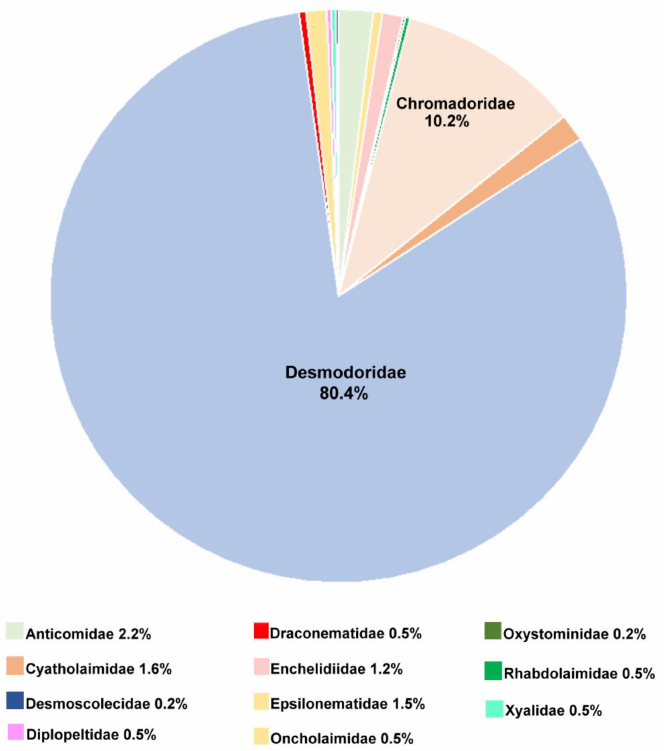
Figure 14. The proportion of families (numbers of individuals) in the total nematode population of demosponges.